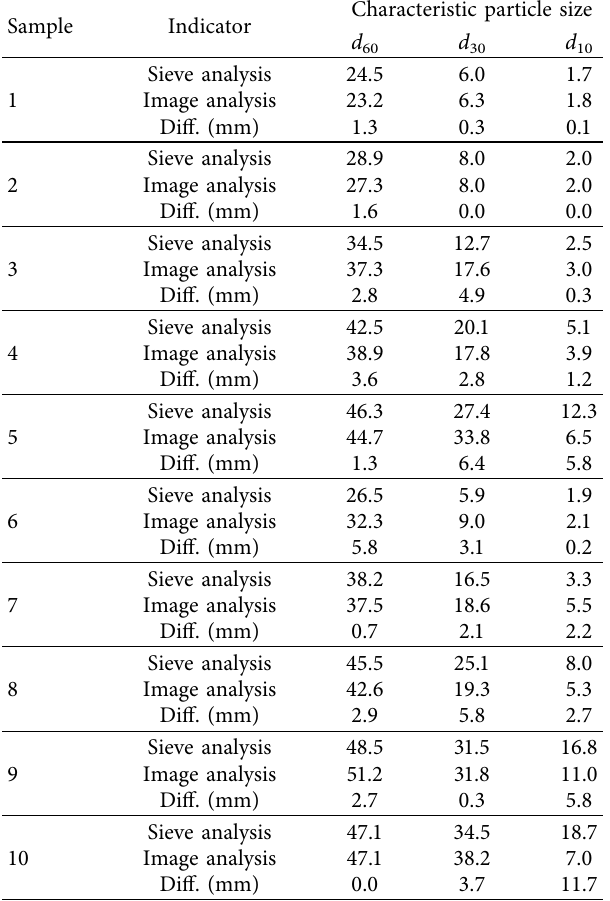
Table 1: Characteristic particle size indicators of limestone ag- gregates with different gradation.